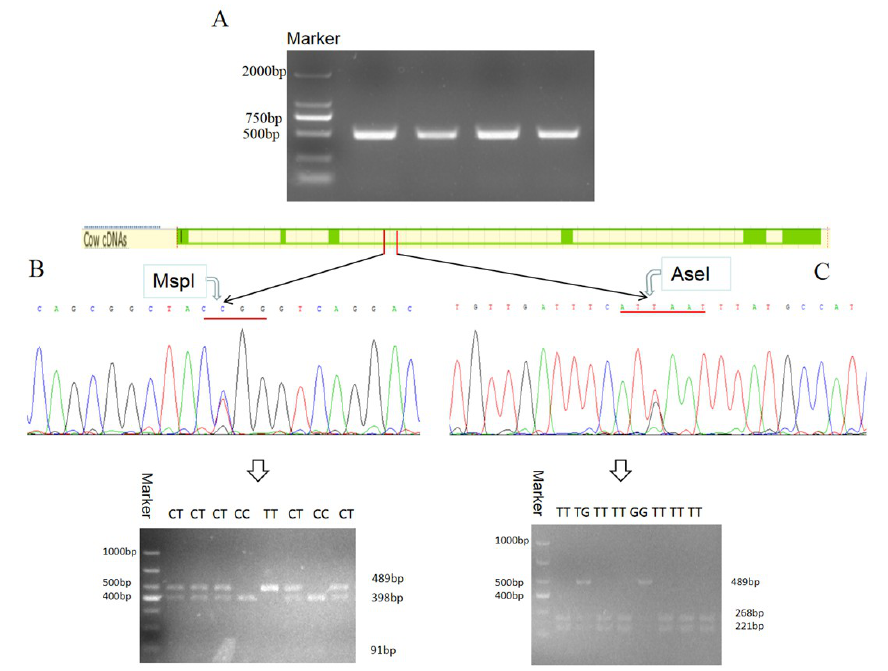
Figure 7. Detection and genotyping of Single-nucleotide polymorphism sites (SNPs) of the DLK1 gene ( A ). Both SNPs have three genotypes, one (IVS3 + 478 C > T) had the CC, CT, and TT genotype ( B ),